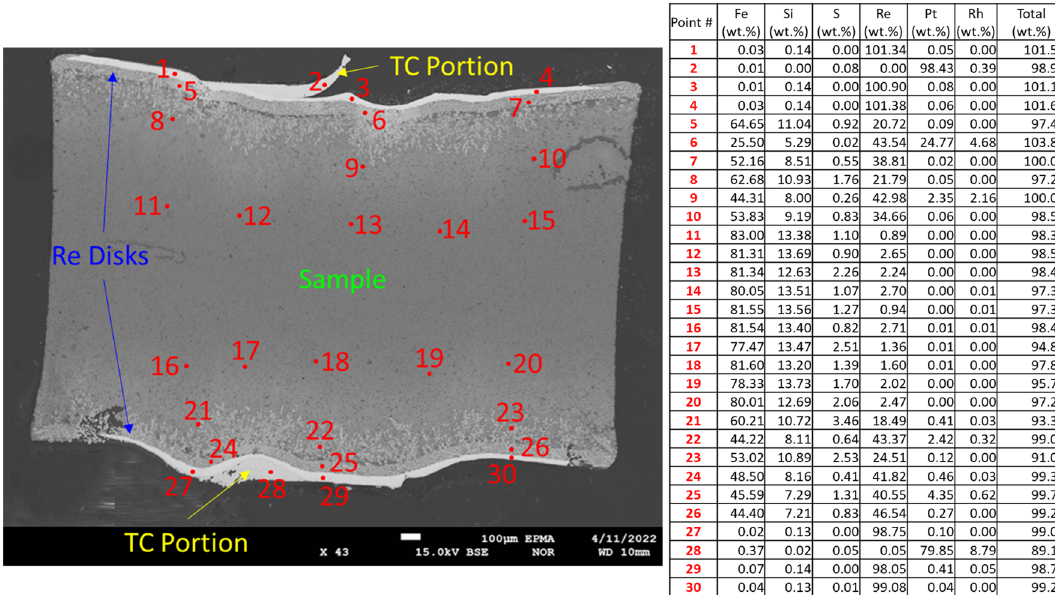
Figure 1. Backscattered electron image of a cross-section of the 4 GPa sample extracted from the pressure cell post-experiment and -heating up to ~ 1980 K, ~ 300–400 K above expected melting temperatures. Portions of the thermocouple (TC), rhenium (Re) disks, and bulk sample have been annotated alongside microprobe locations. Results of the microprobe have been